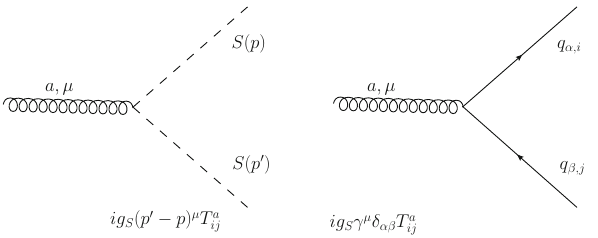
Fig. 3 Feynman rules that are required for the calculation of the con- tribution of a scalar LQ to the t → cg decay. Here T a are the SU ( 3 ) c generators in the fundamental